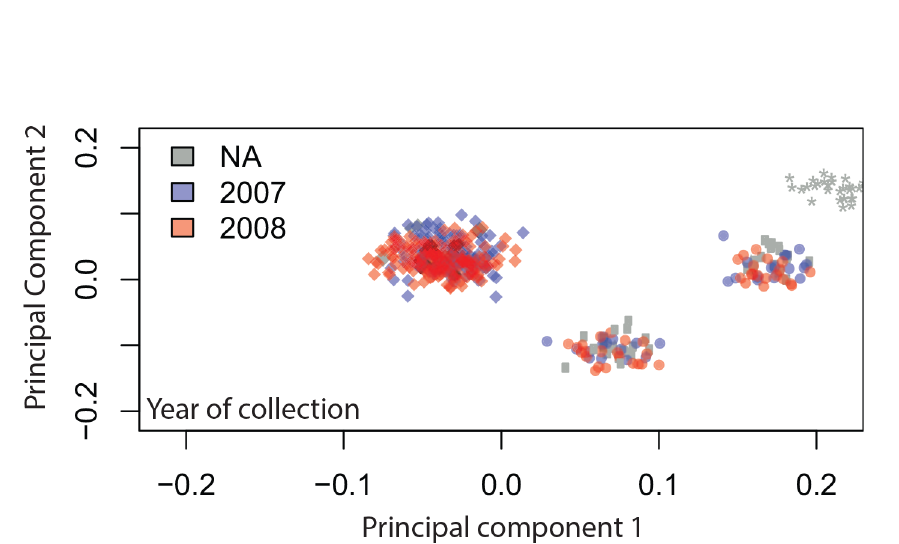
Fig 2. Identical population substructure is detected with half the number of SNPs. The same PCA analyses as in Fig 1 were repeated with 400 randomly sub-sampled SNPs, revealing the same four population subgroups. Panel labels (A-F) as in Fig 1. Note the Principal Component 2 is in opposite polarity to Fig 1, hence the presence of the A . arabiensis cluster in the lower right hand corner. Circled cluster indicates individuals belonging to the Goundry form.